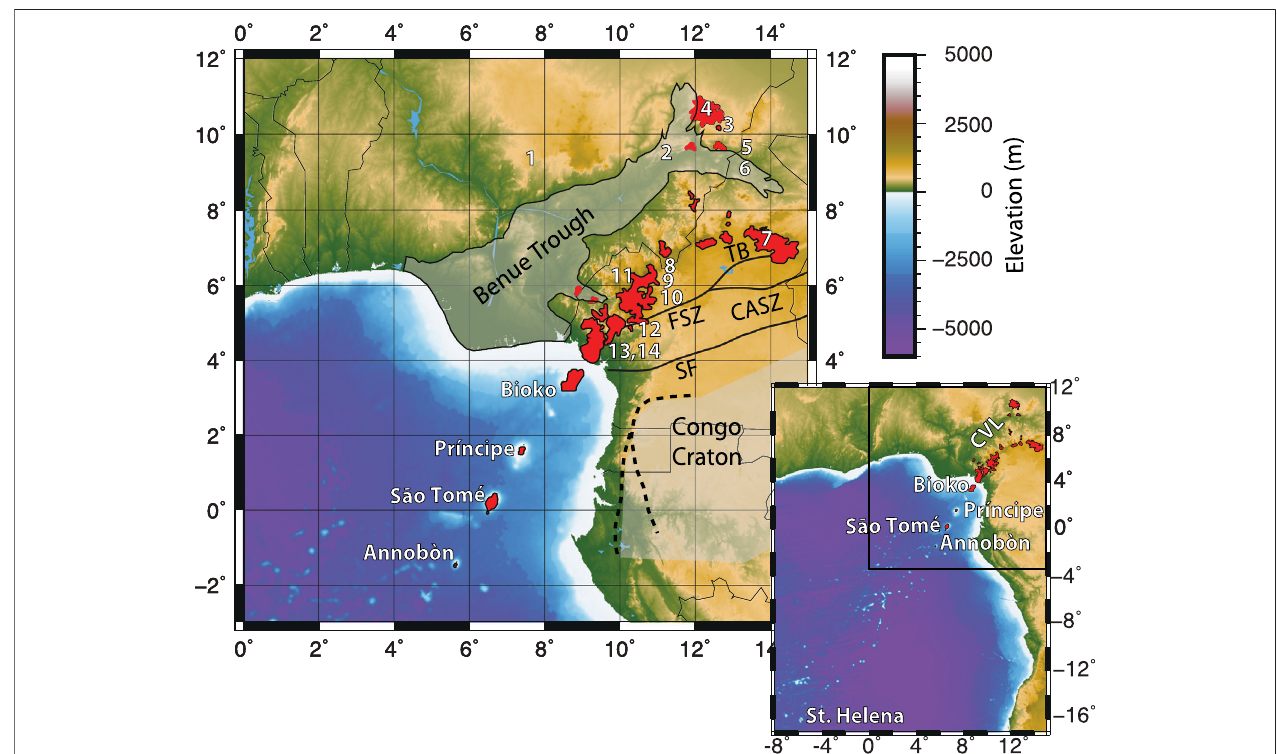
FIGURE 1 | Geologic map of the CVL and surrounding regions. Volcanic provinces of the CVL are shown in red, and the Congo Craton and the Benue Trough are shadeingray.BoldlinesrepresenttheCASZ,includingtheFoumbianShearZone(FSZ),Tcholliré-BanyoShearZone(TB),andtheSanagaFault(SZ).Whitenumbersand labelsindicate thelocations ofvolcanic centersdatedin Figure 2 .TheinsetshowstheCVL inrelation toSt. Helena andnearbyseamounts. Theareaoftheprimarymap is shown with a black rectangle.